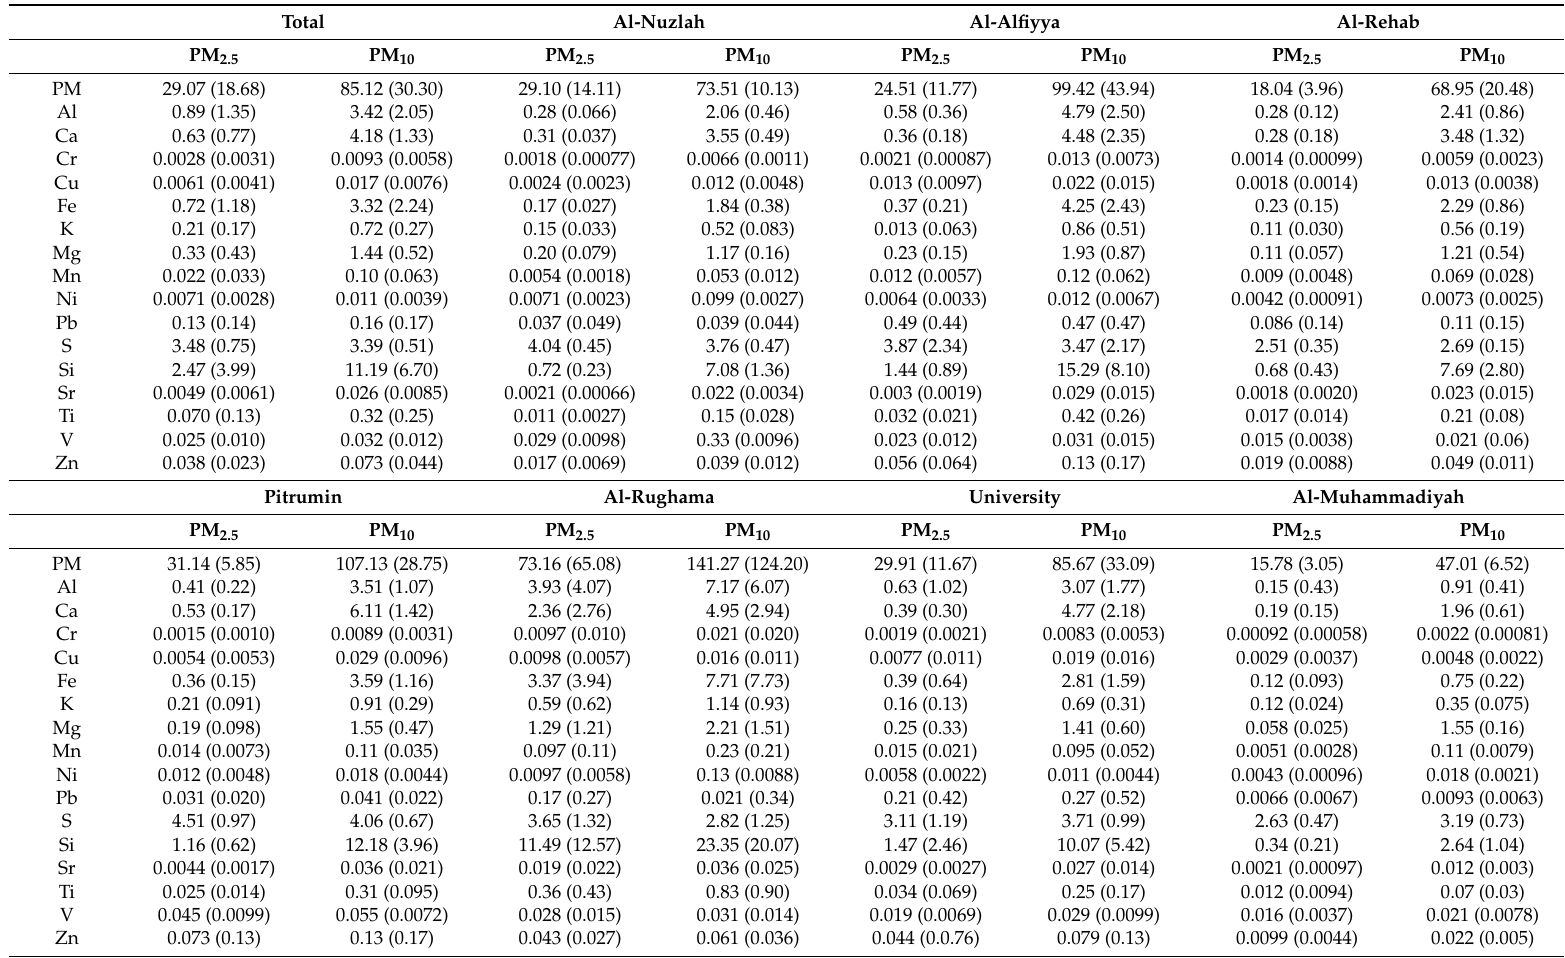
Table 2. PM and elemental constituents concentration levels (Mean ± S.D., µ g/m 3 ) by